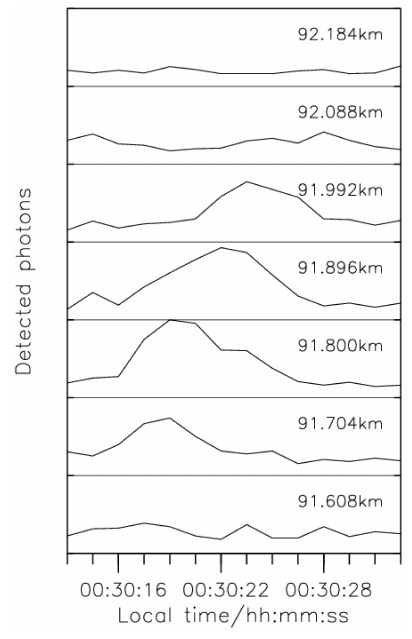
Figure 15. Temporal variation of the lidar returned signals at differ- ent altitudes, corresponding to Fig.